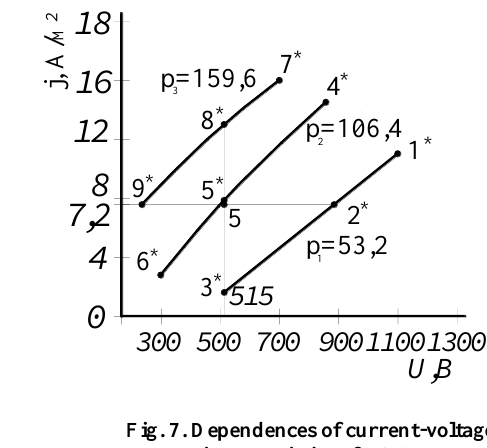
Fig. 7. Dependences of current-voltage characteristics of BATR on the pressure of the gas